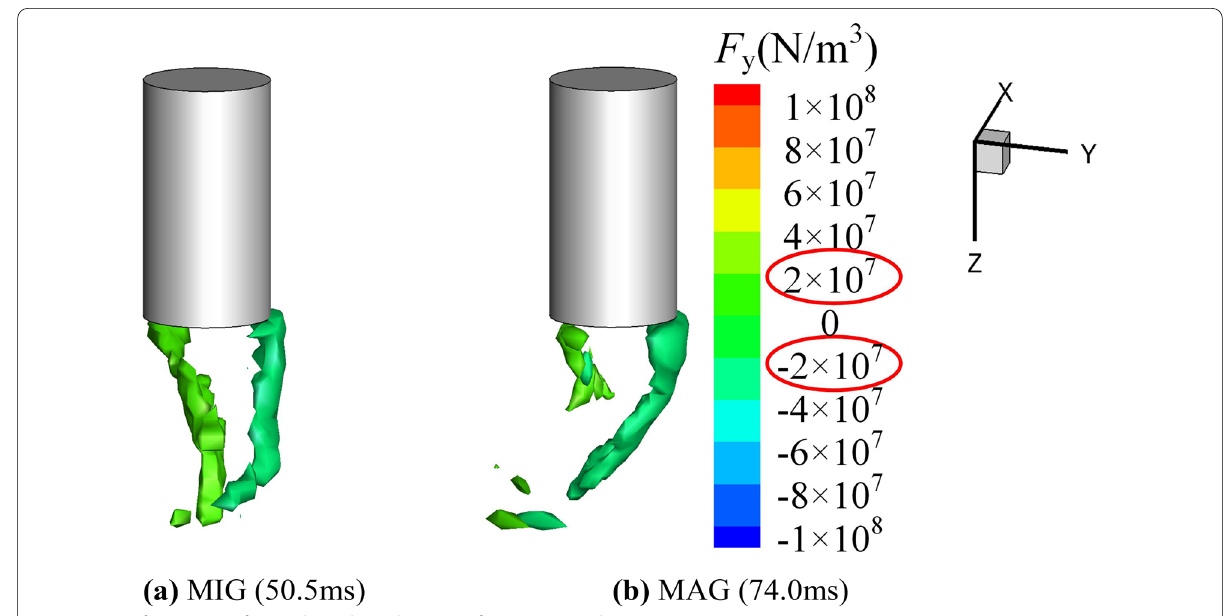
Figure 8 Surface tension forces along the y-direction of 500 A MIG and